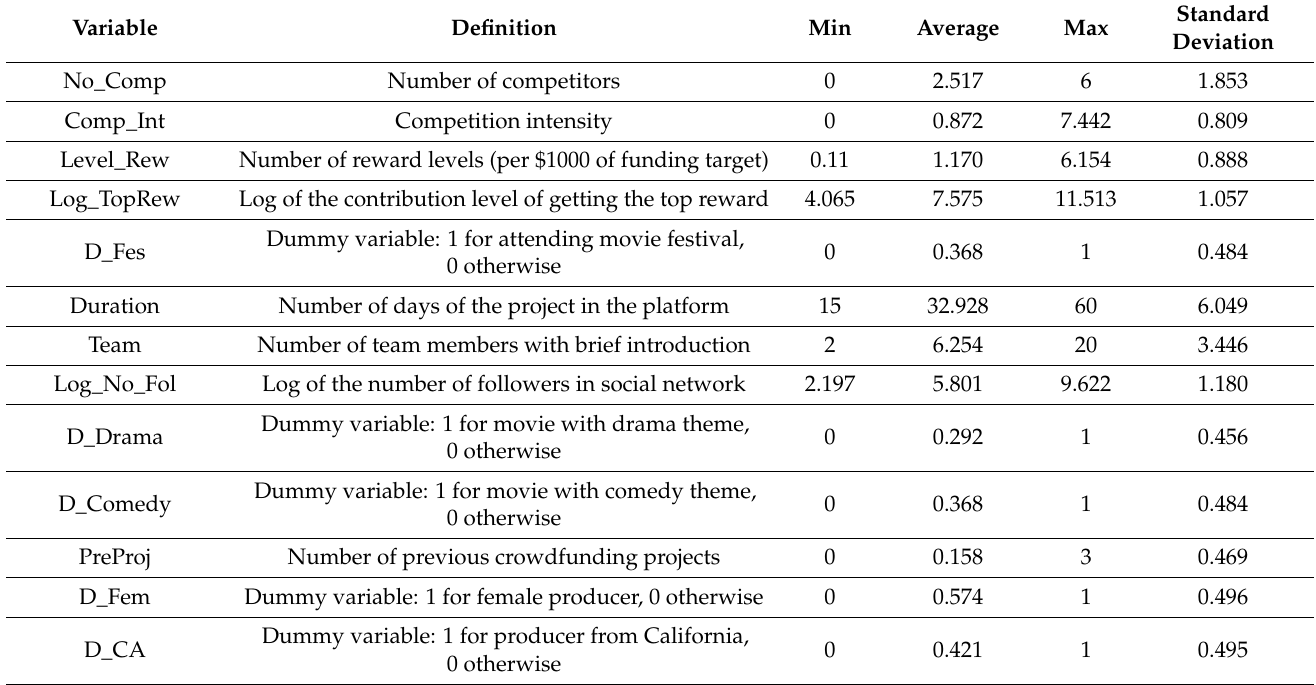
Table 1. Summary